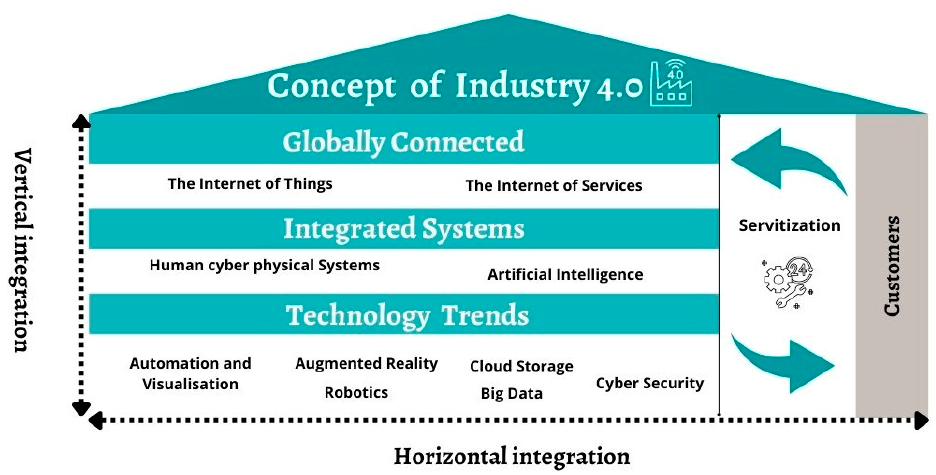
Figure 1. Scheme of Industry 4.0 integrating cornerstones.